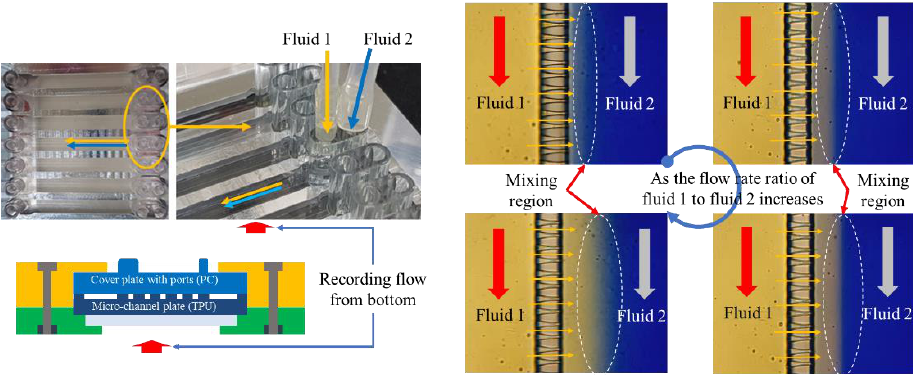
8 of 12 Figure 11. Experiment set-up for flow and mixing test or synthesizing liposome using micro-chan- nel device. When we supplied yellow and blue water to the inlet ports, some microscopic images were taken on interfacial regions of yellow and blue water along the recovery channel where two fluids mixed, with the neighboring region including micro-nozzle array and